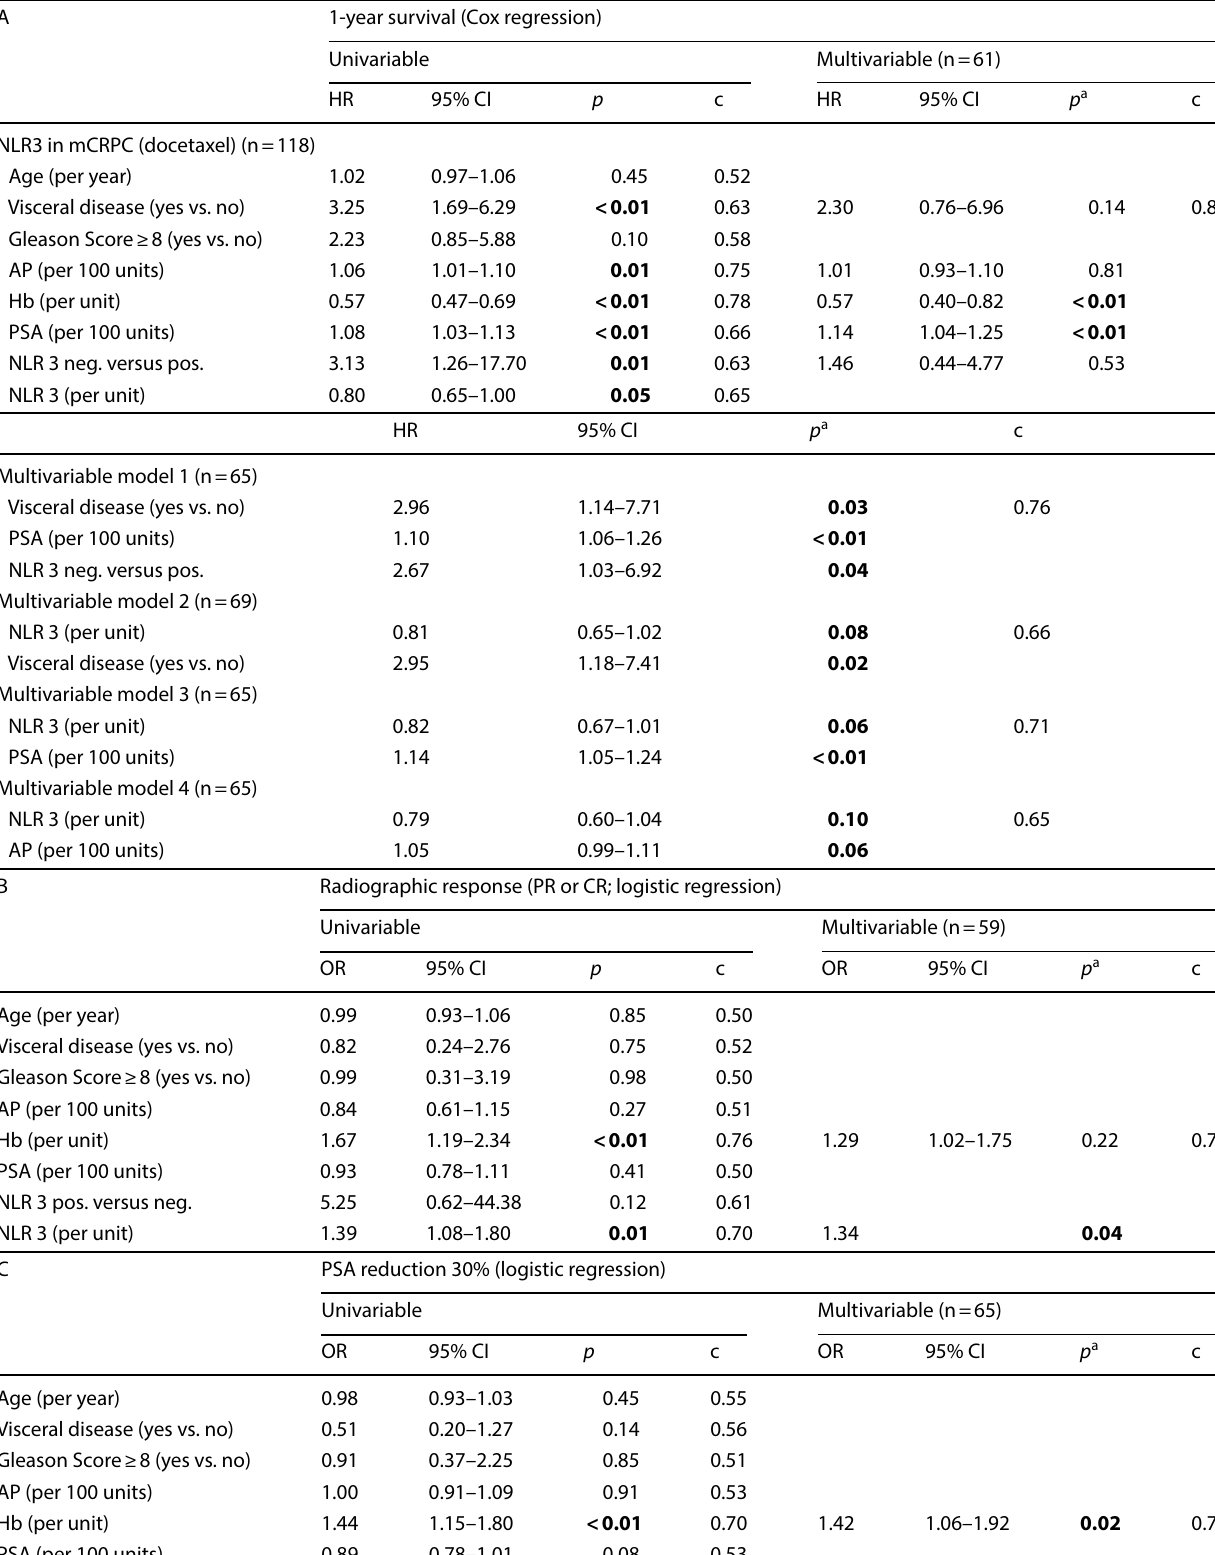
Table 3 Uni- and multivariable logistic and Cox-regression in the mCRPC cohort treated with docetaxel to detect variables associated with the A 1-year survival B radiographic response C and D biochemical response A 1-year survival (Cox regression)